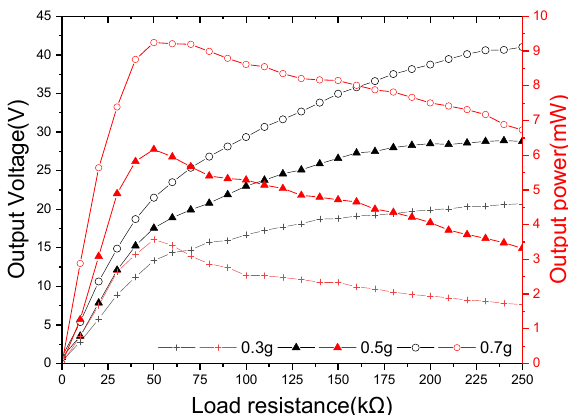
Figure 11. The peak output voltages (dashed lines) and peak output powers (solid lines) against various load resistances at the resonant frequency of 7.7 Hz under varying base acceleration.